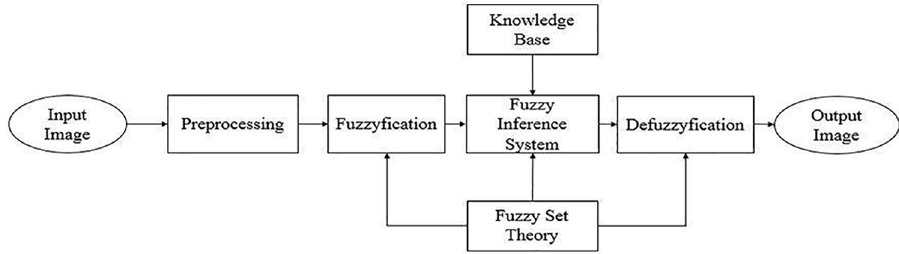
Fig 2. Block diagram of the developed edge detection approach through fuzzy